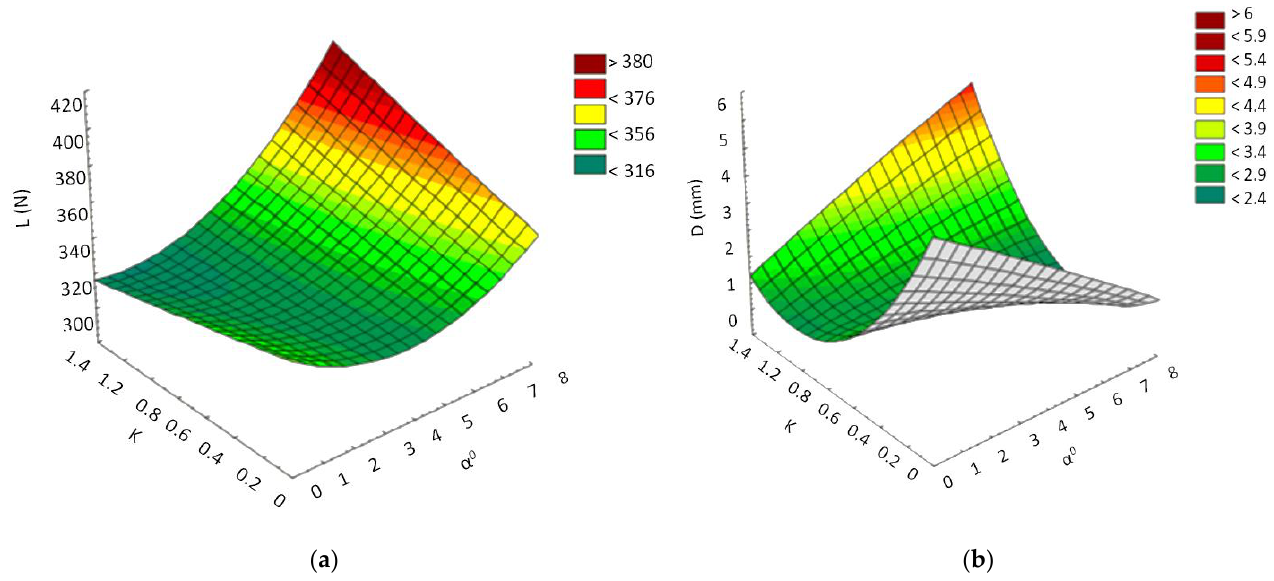
Figure 6. Graphs of the response area of the force of K and α ° ( a ) and the displacement D, as a function of α ° and K ( b ).